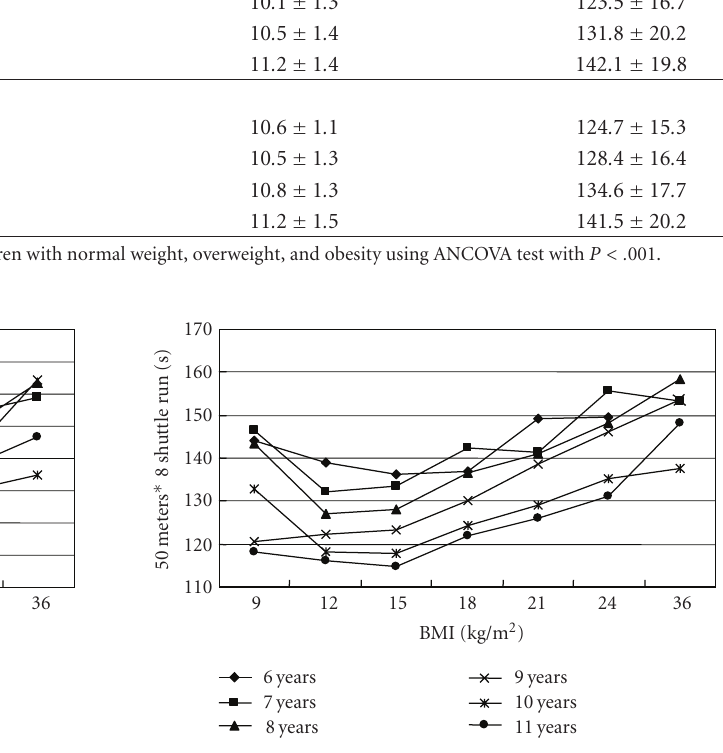
Figure 2: The association of 50 m sprint time (s) with BMI (kg/m 2 ) in 6775 Chinese children aged 6–11 years.